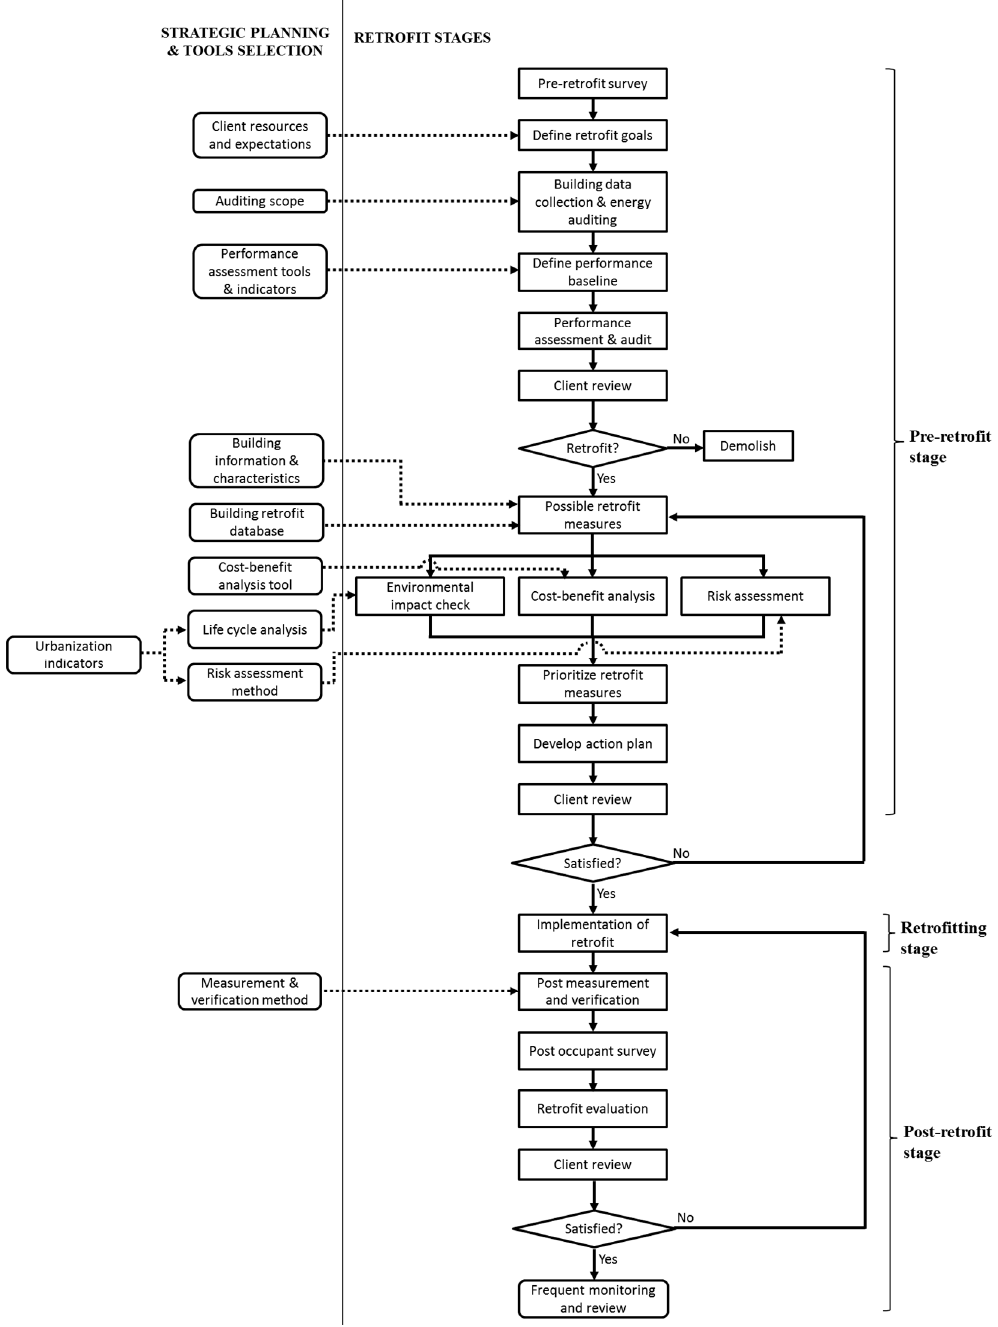
Figure 10. Methodical algorithm for green building retrofit measures [modified from Ma, Cooper [16]].